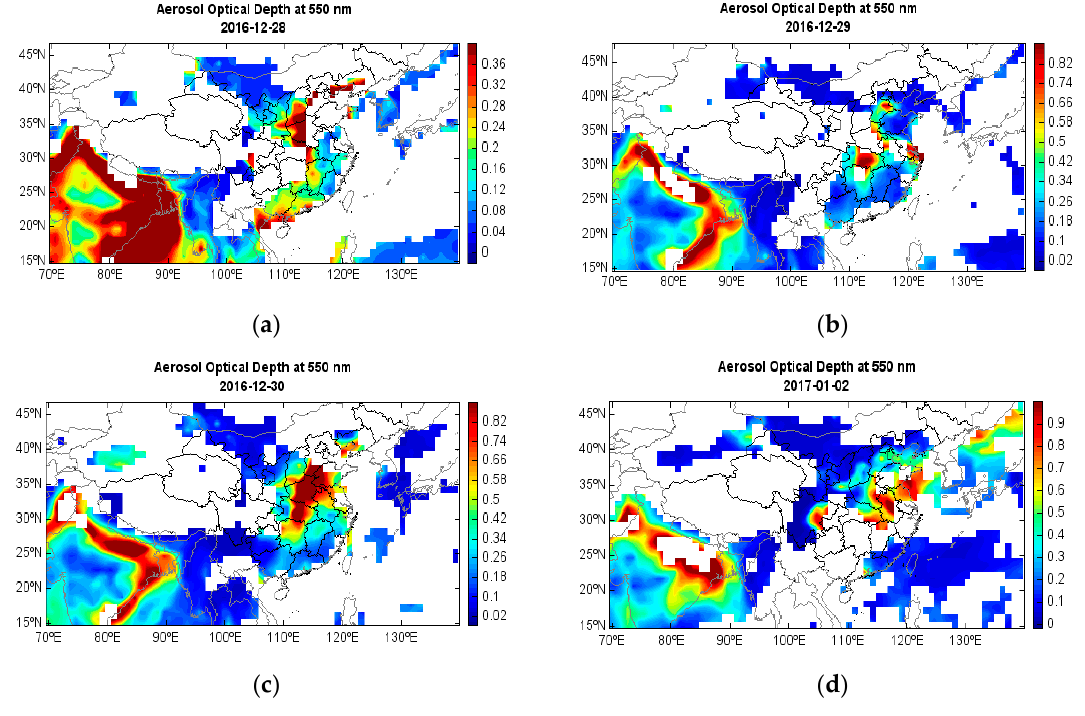
Figure 11. VIIRS deep blue AOD at 550 nm in Huainan.